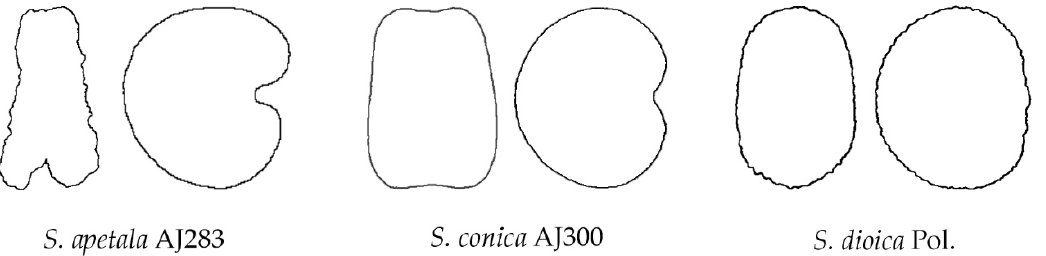
Figure 7. Dorsal and lateral average silhouettes for the images of 20 seeds of S. apetala AJ283, S. conica AJ300, and S. dioica Pol.